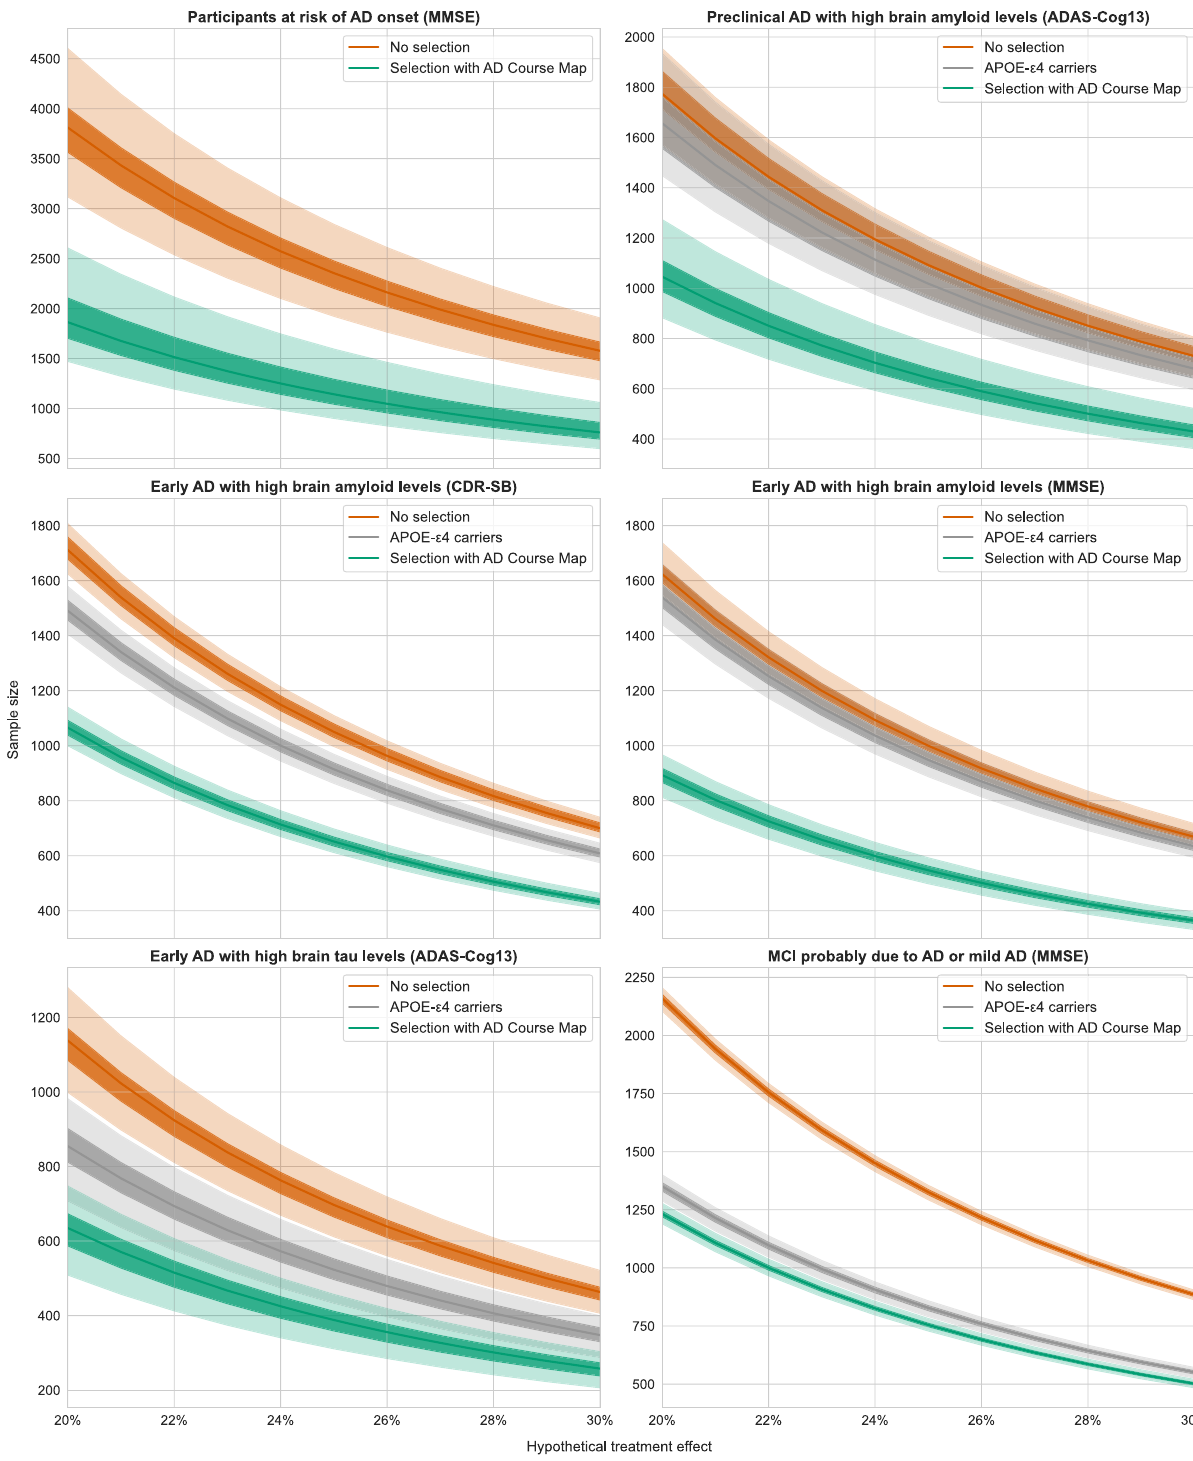
Fig.6|EnrichmentbasedonADCourseMapsigni fi cantlydecreasesthesample size for a hypothetical treatment effect ranging from 20% to 30%. Reported sample sizesarethe totalsize for twoarms. The light-shaded areas represent the 95% con fi denceintervalandthedark-shadedareasthe50%con fi denceintervalaroundthe